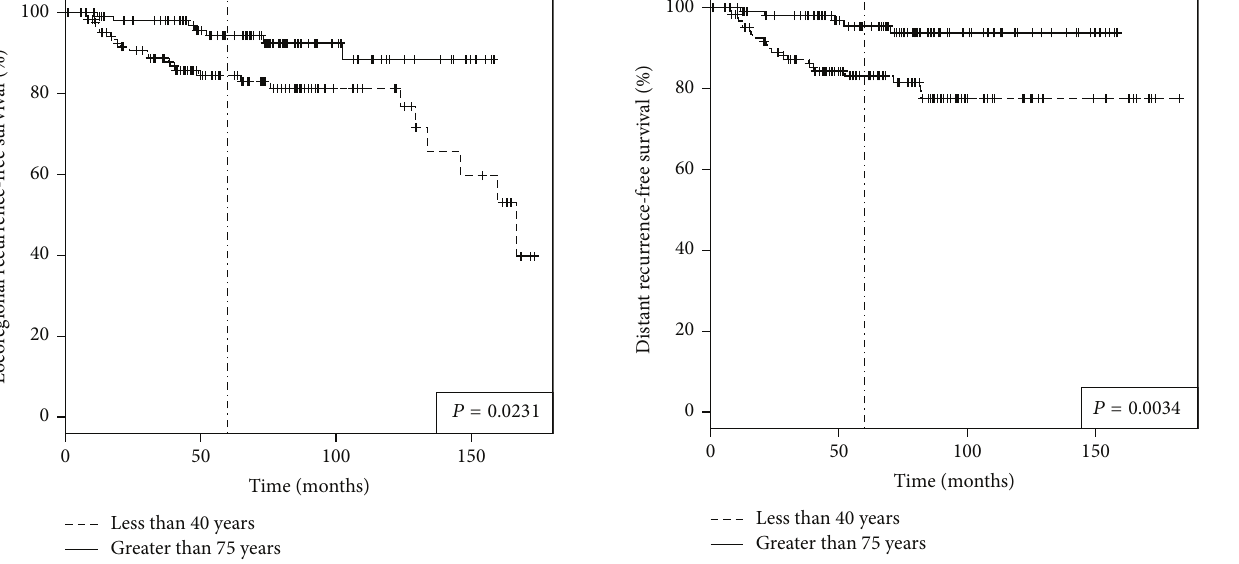
Figure 1: Locoregional recurrence-free survival (LRFS) in breast cancer patients based on patient age. Women younger than age of 40 had a significantly worse LRFS than those above the age of 75. The 5-year rate of LRFS was 84.5% versus 94.3% ( 𝑃 = 0.0231 ).